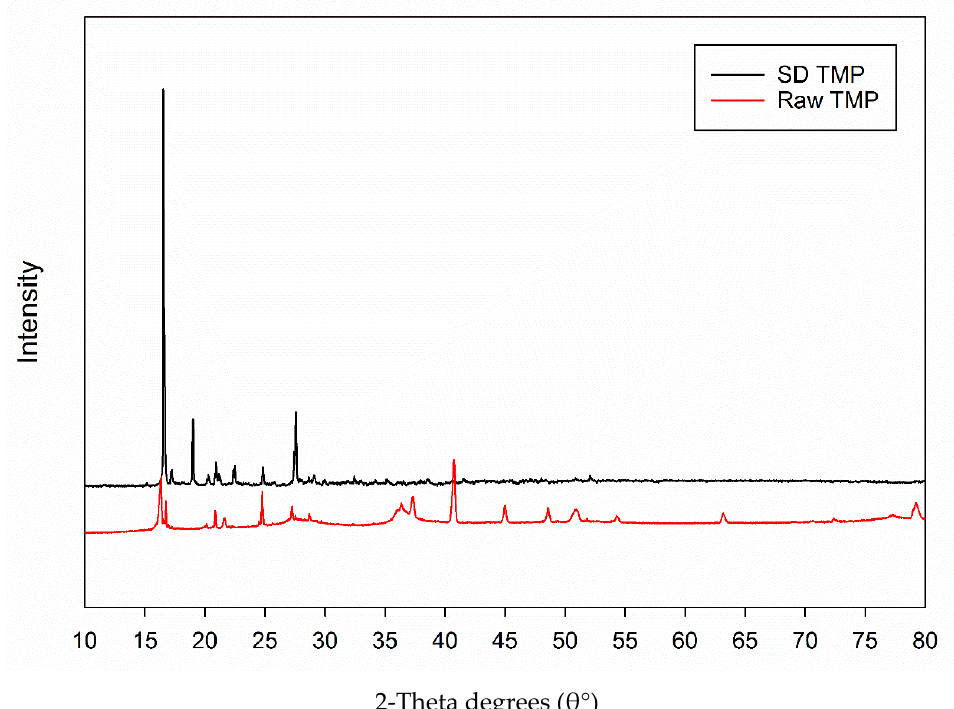
Figure 3. X-Ray powder diffractograms of raw TMP and SD TMP. 2. Figure 3. X-ray powder diffractograms of raw TMP and SD